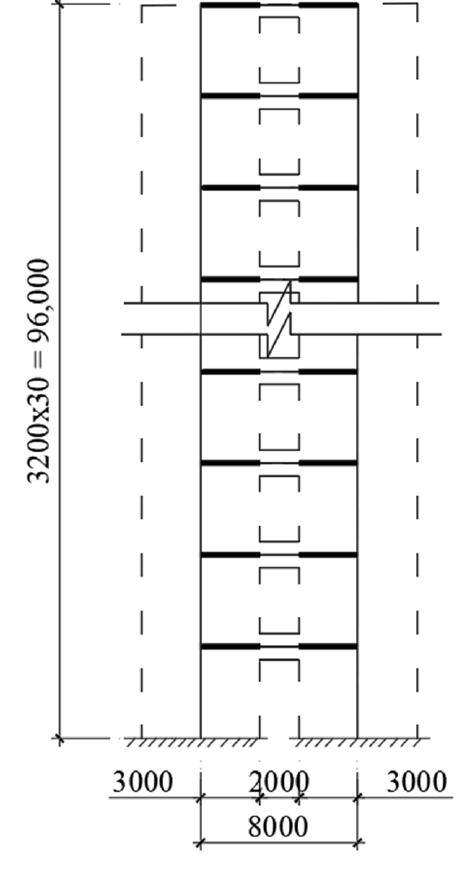
Figure 19. 30-story coupled shear wall.